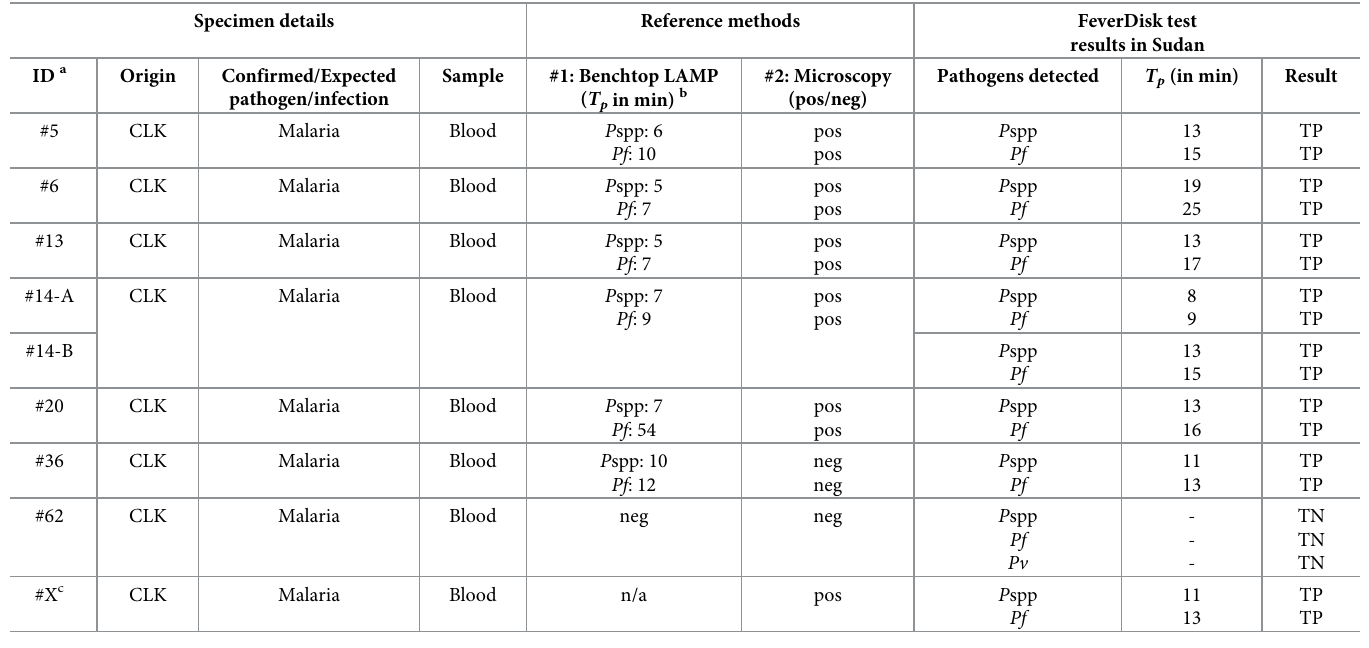
Table 2. Overview of results from the test series in Sudan where 9 FeverDisks were used. The reference methods as well as the FeverDisk results are shown. Specimen